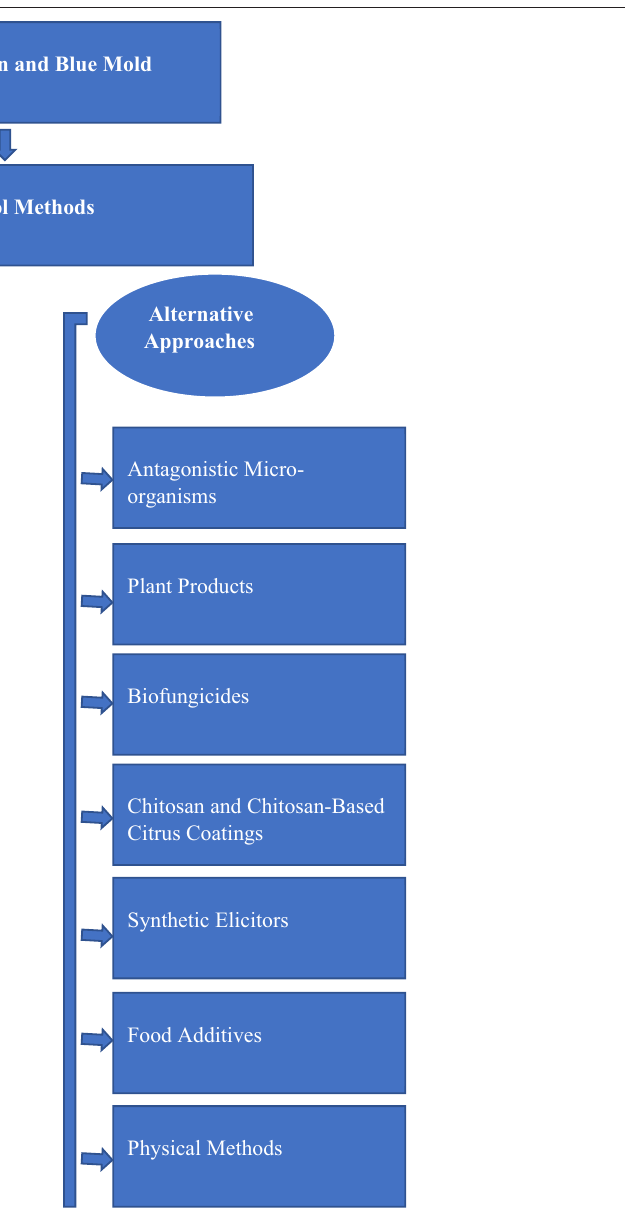
FIGURE 1 | PRISMA flow diagram of the citrus green and blue mold management